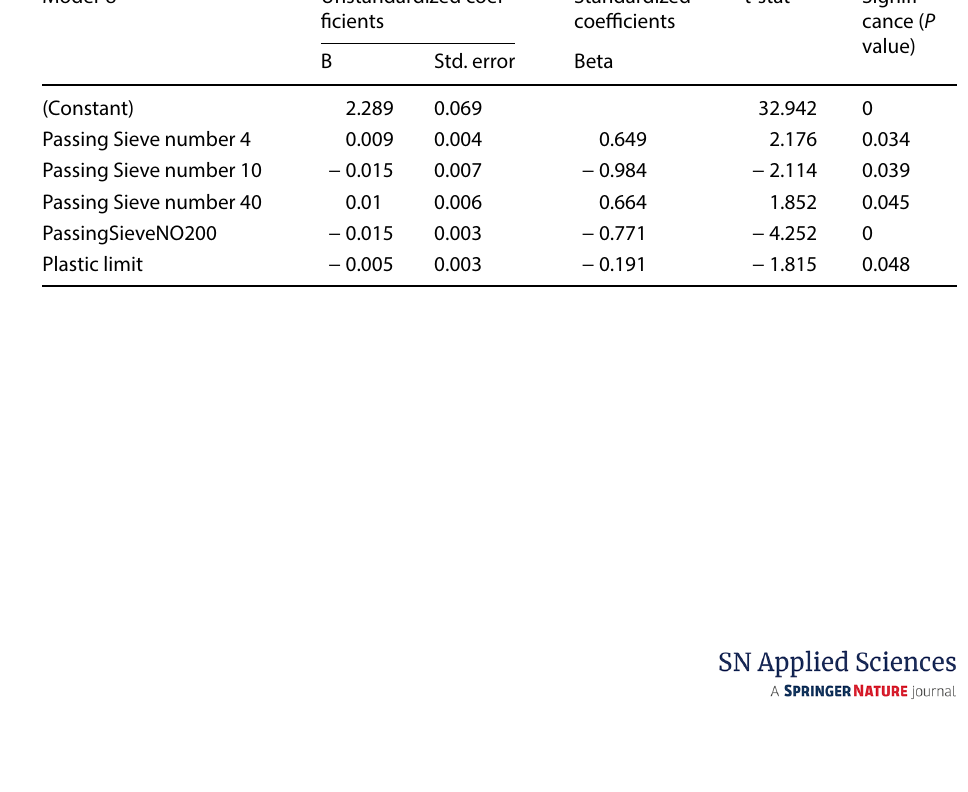
Table 9 The MLR model for predicting the